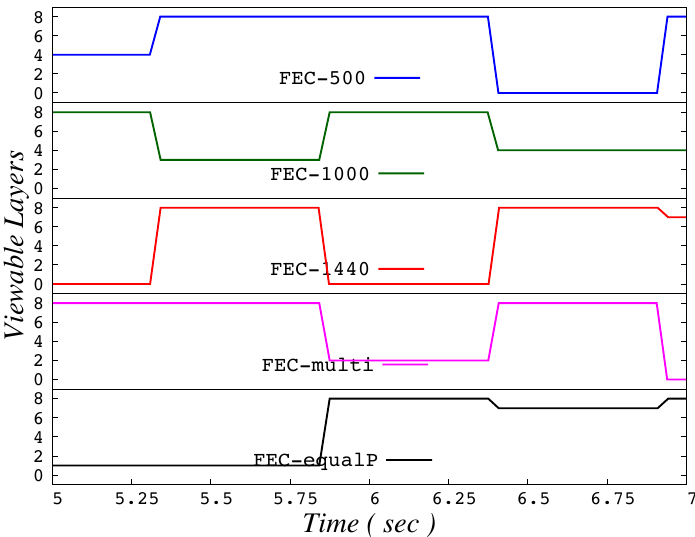
Figure A18. A two-second example of variation in viewable quality for all FEC schemes, at a packet loss rate of 10% and a GOP of 16.